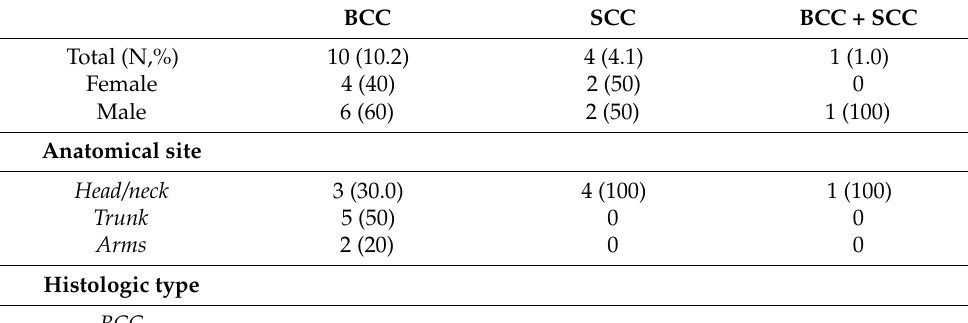
Table 3. Clinical and histological characteristics of NMSC in patients with